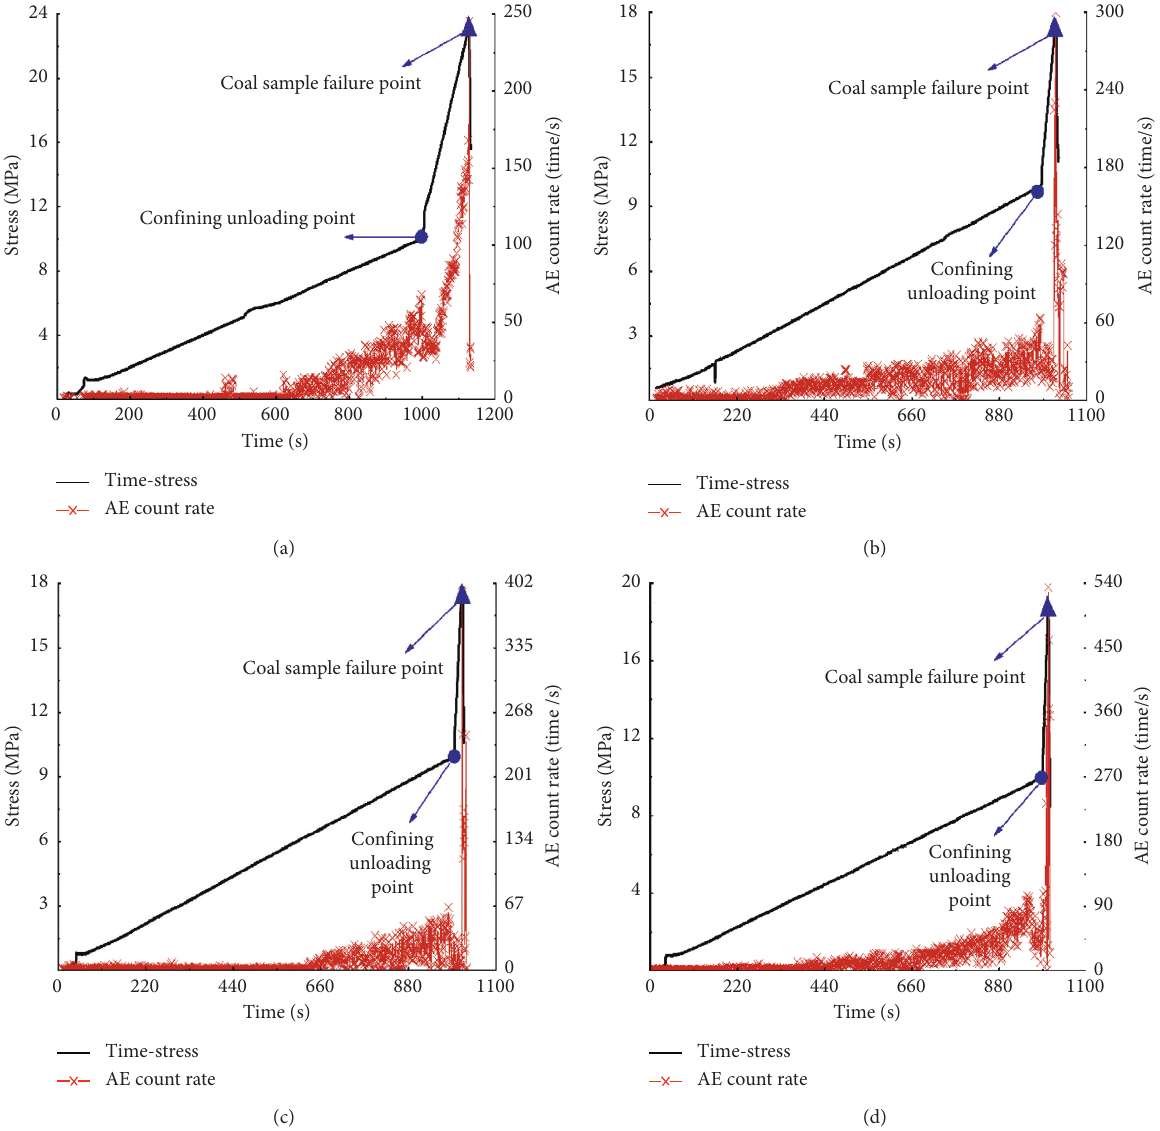
Figure 8: Corresponding curves of AE count time under different unloading rates. (a) 0.1 MPa/s unloading rate. (b) 0.2MPa/s unloading rate. (c) 0.4MPa/s unloading rate. (d) 0.6MPa/s unloading